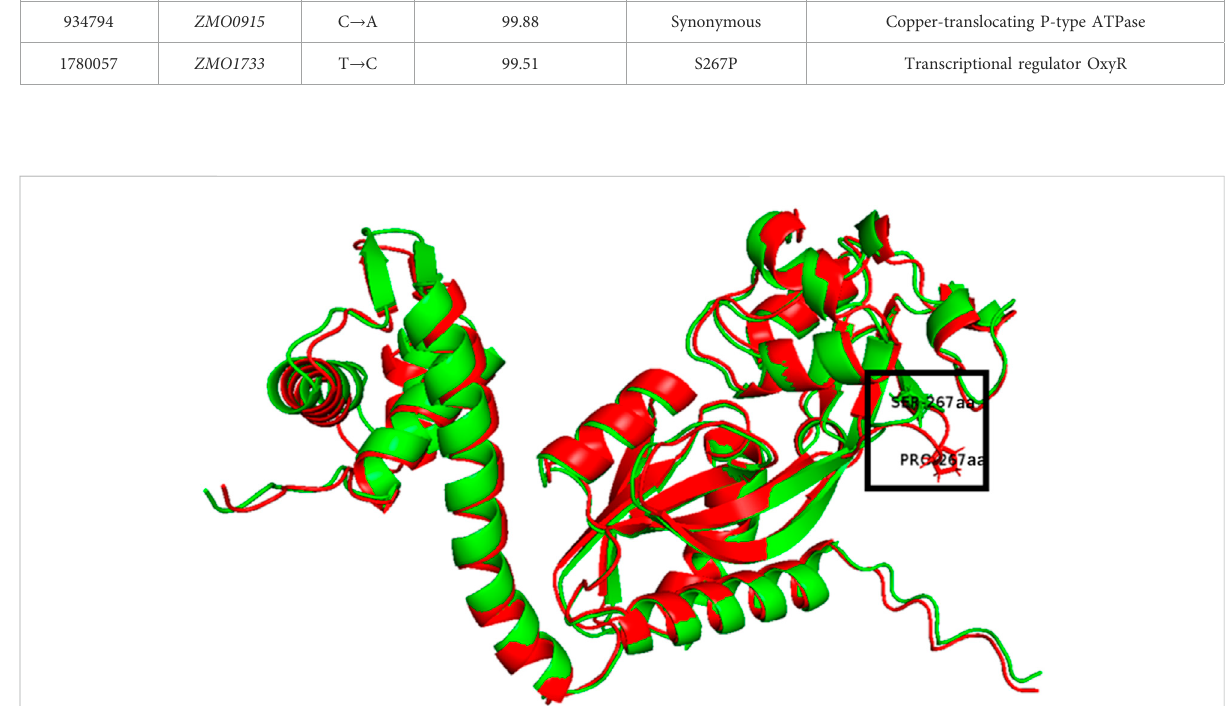
FIGURE 3 Overlay of the 3D structures of predicted OxyR mutant (Red) and wild-type OxyR protein